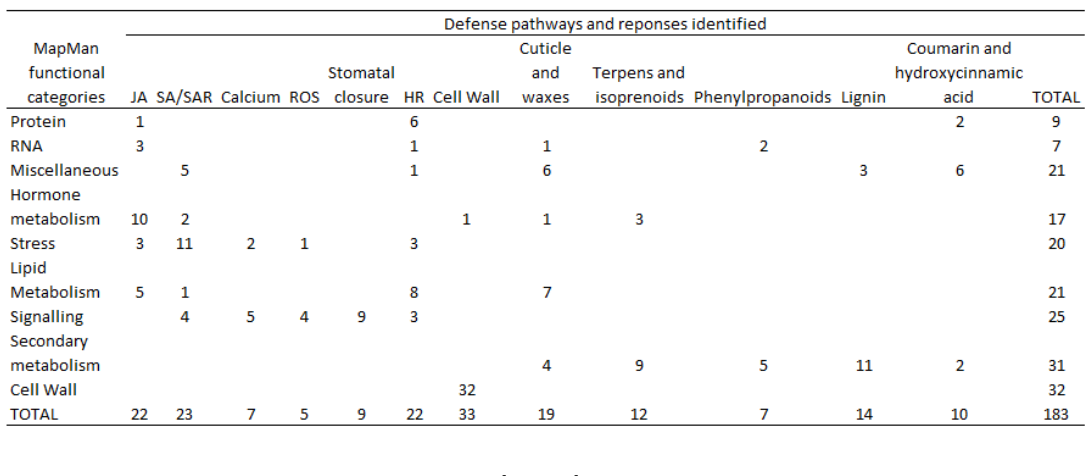
Table 3 : Numbers of DEGs in the defense pathways and responses identified among the